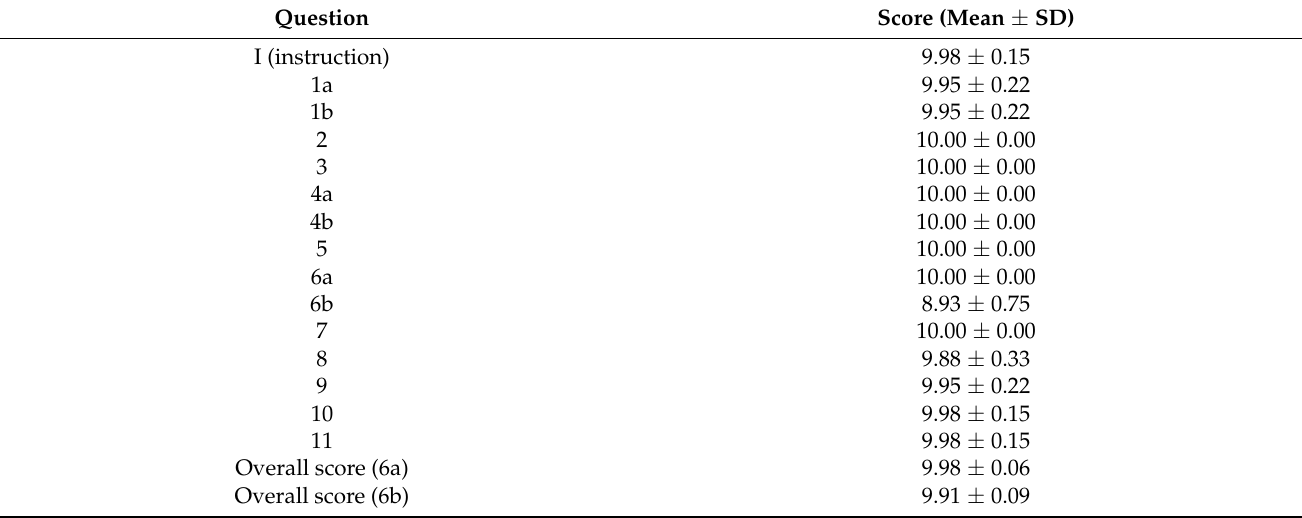
Table A2. The Score for Clarity and Comprehension of the GMAS of Patients (Stage V).